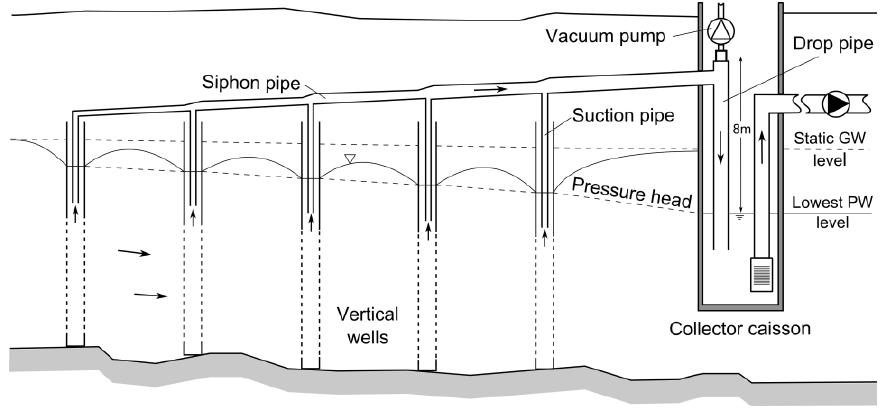
Figure 1. Schematic of five siphon wells and one collector caisson.